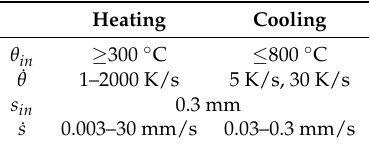
Figure 4. Schematic thermal and axial stroke profiles in the tests during ( a ) heating and ( b ) cooling. Table 2. Summary of test